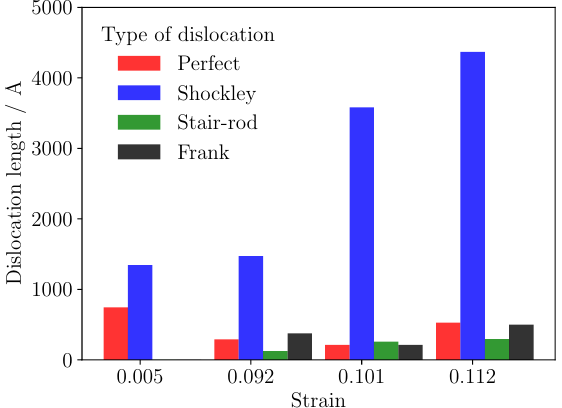
Figure 7. Summary of didderent types of dislocation under different